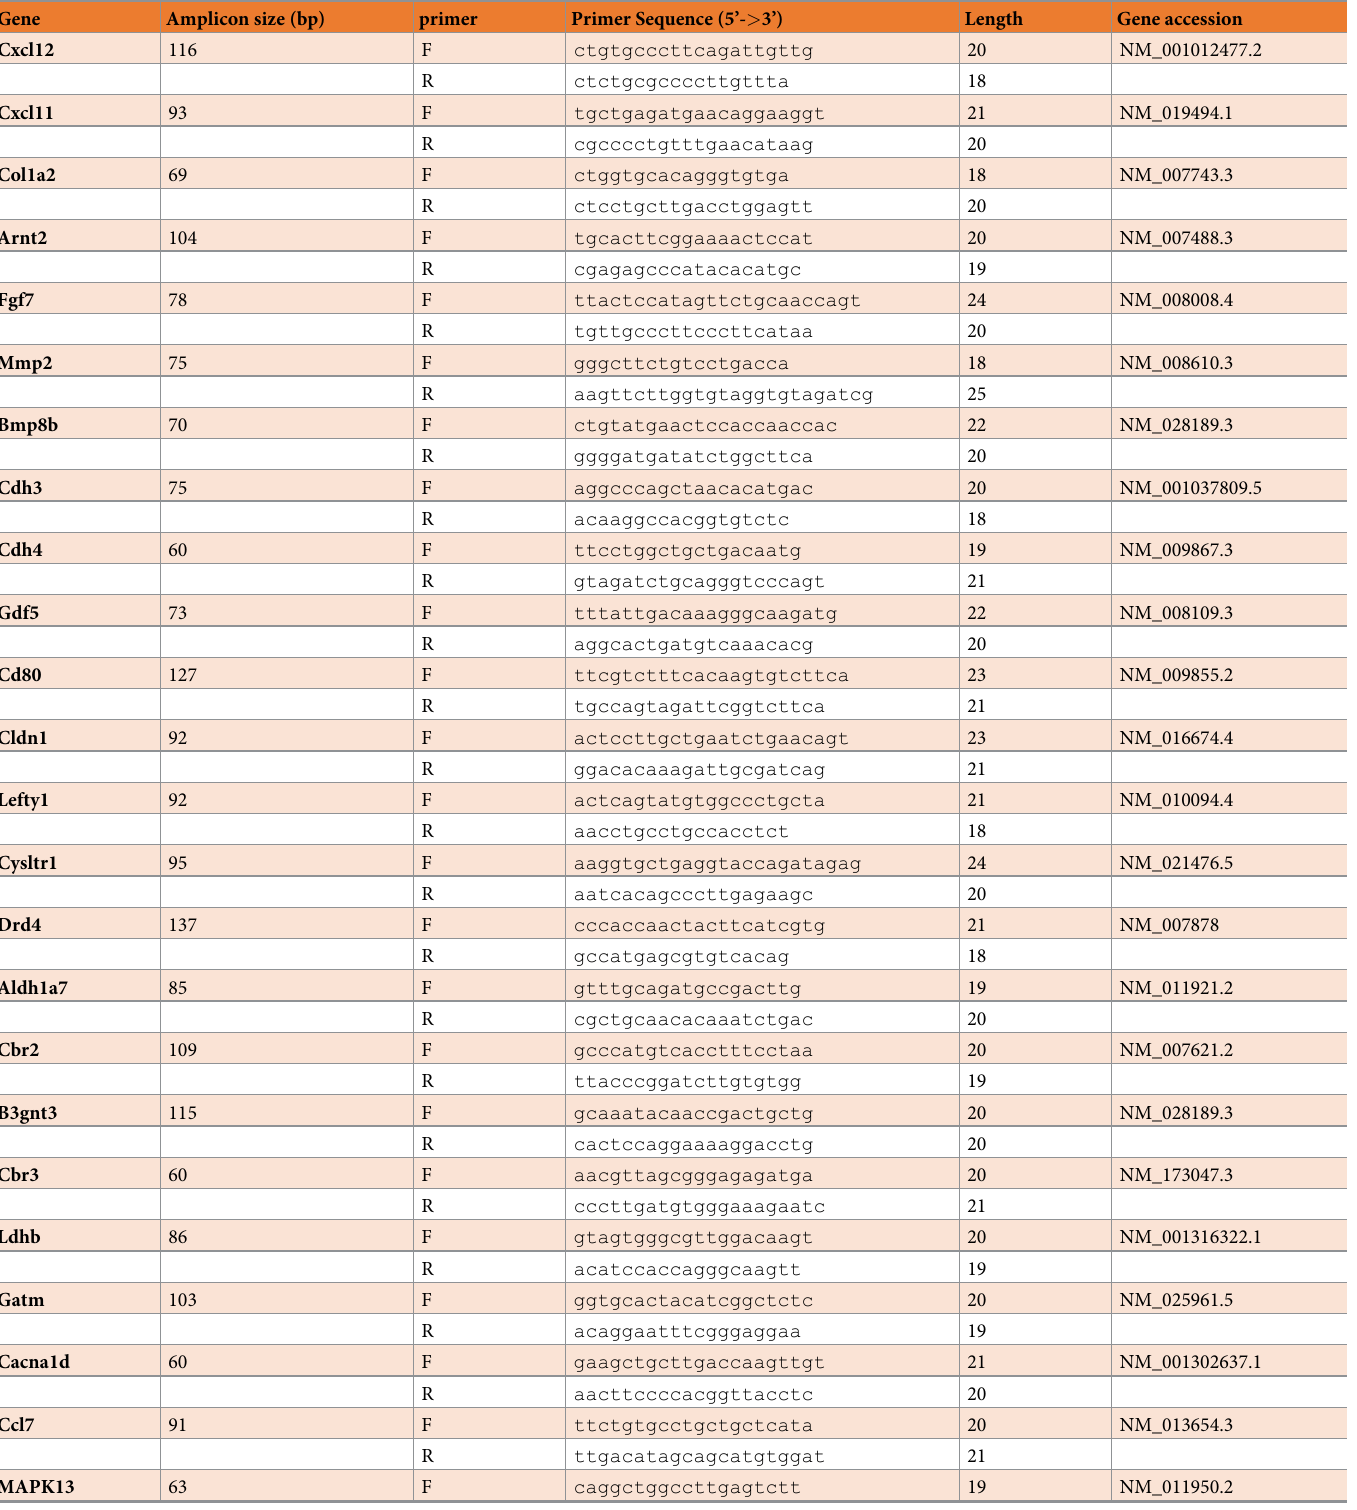
Table 4. Primers to validate differentially express